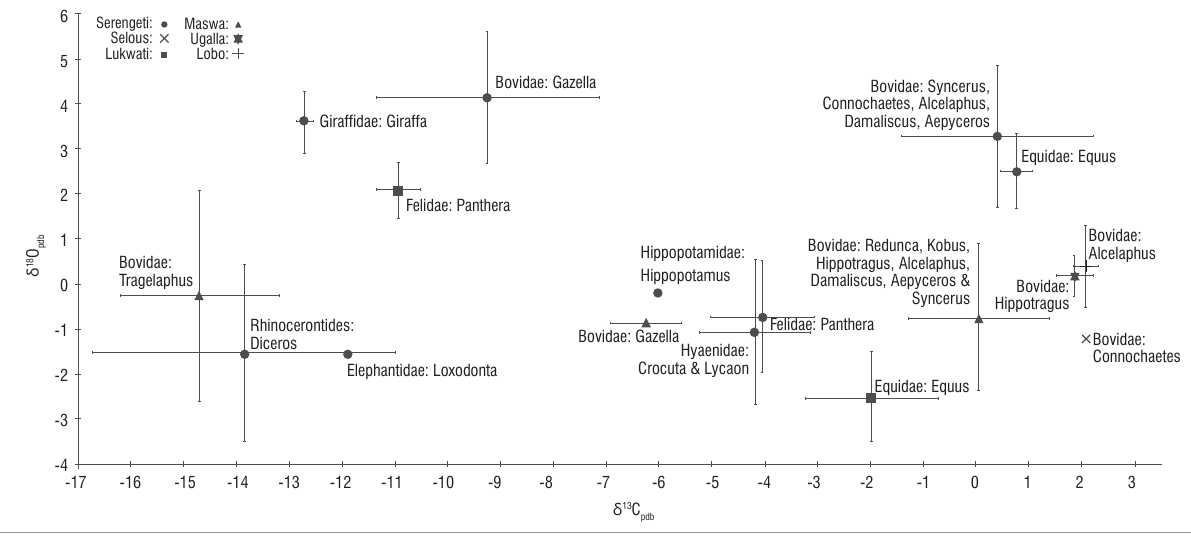
Figure 3: δ 13 C and δ 18 O values obtained from tooth enamel of modern fauna from Serengeti, Maswa, Lobo, Ugalla, Lukwati and Selous wildife reserves.